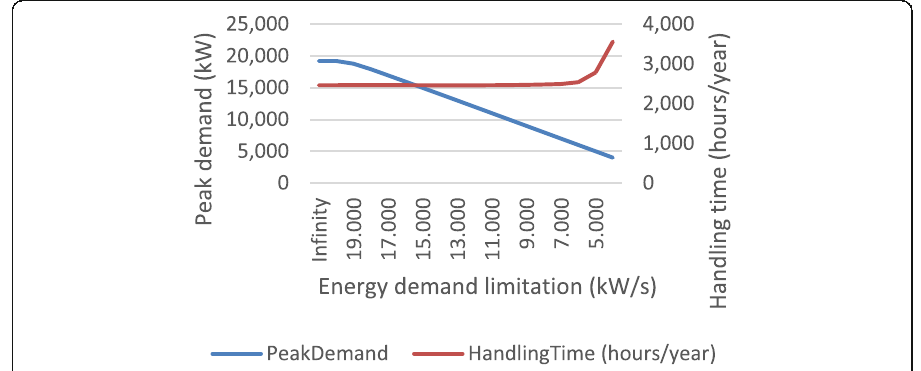
Fig. 9 Relation between peak demand and handling time when maximum energy demand is